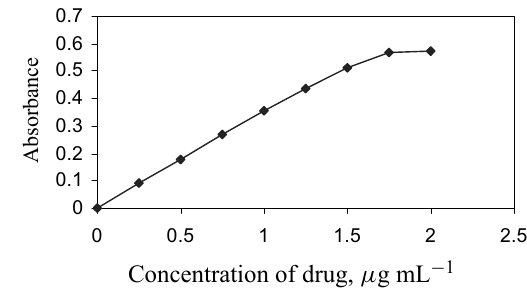
Fig. 2 – Beer’s law curve for method A.